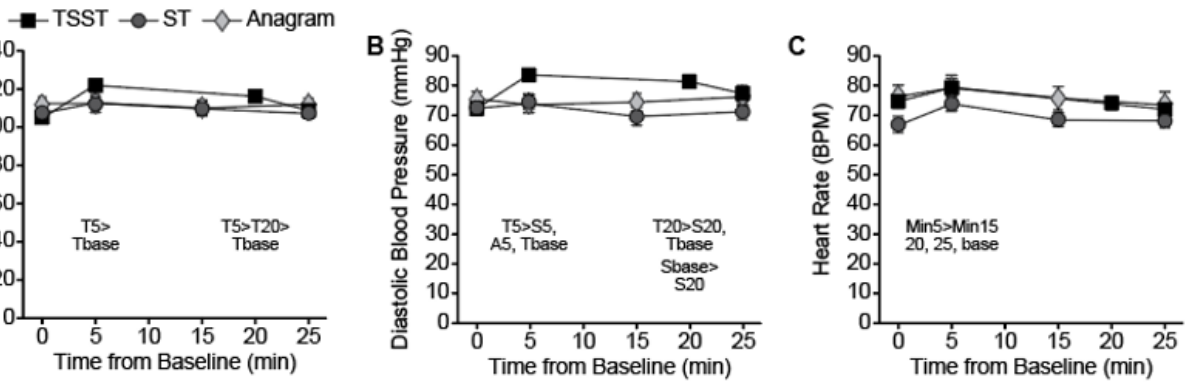
Figure 3. Cardiovascular response to laboratory stressors. ( A ) Systolic blood pressure was elevated during the TSST at 5 min and 20 min. ( B ) Diastolic blood pressure was also elevated during the TSST at 5 min and 20 min and suppressed during the ST at 20 min. ( C ) Heart rate in all conditions was elevated at 5 min. T = TSST, S = ST, A = anagram, base = baseline. All significant effects are p < 0.05. Table 2. Means and standard deviations of outcome measures.